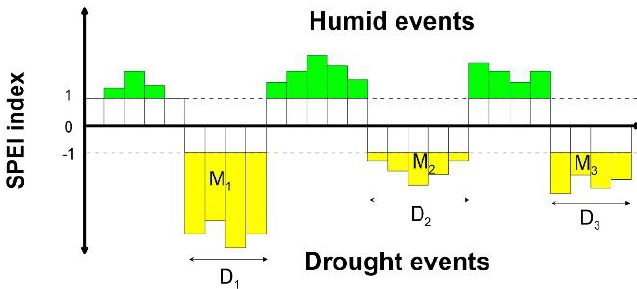
Figure 2. Scheme of drought characterization. M = Magnitude, D = Duration, Severity = M/D.